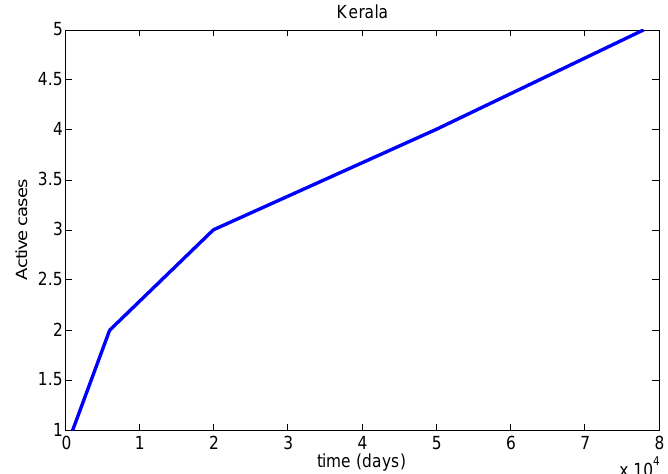
Figure 8. Active cases of Kerala from real life data.